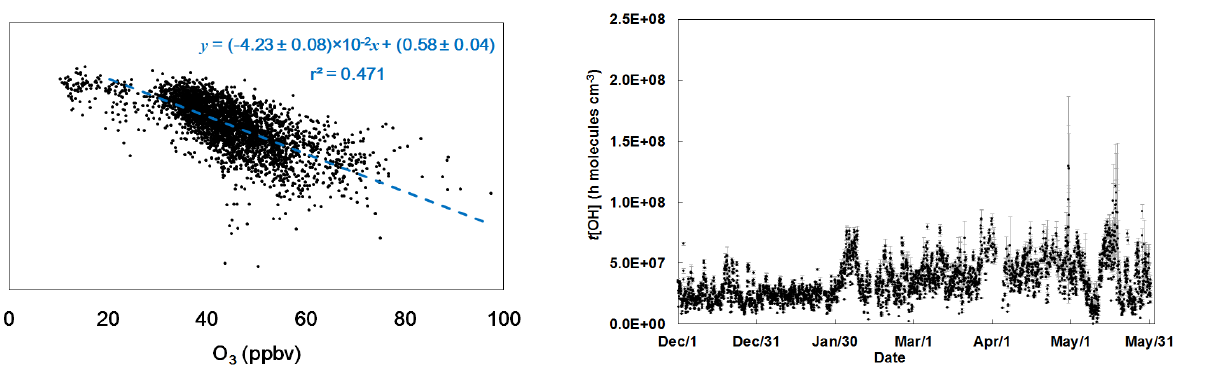
Figure 5. Scatter plot of natural logarithm of [NO x ] / [NO y ] ratio versus O 3 mixing ratio. The data points with the ozone mixing ratios less than 25ppbv were excluded from the linear regression.